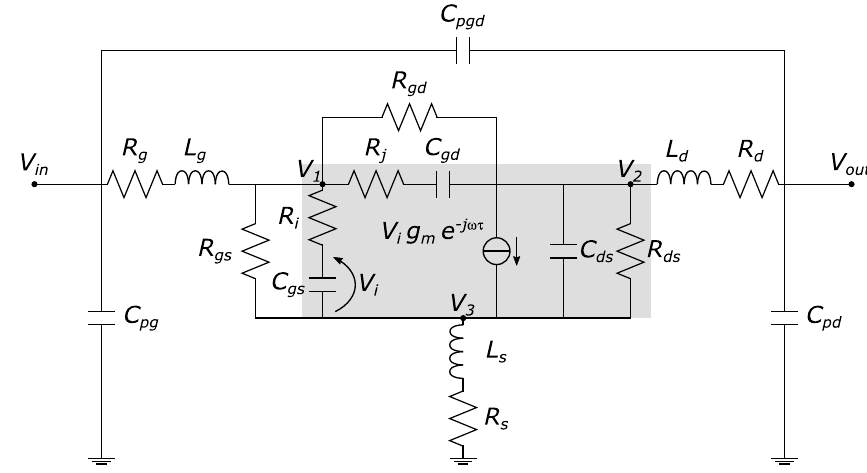
Figure 3. Schematic of the adopted SSEC .